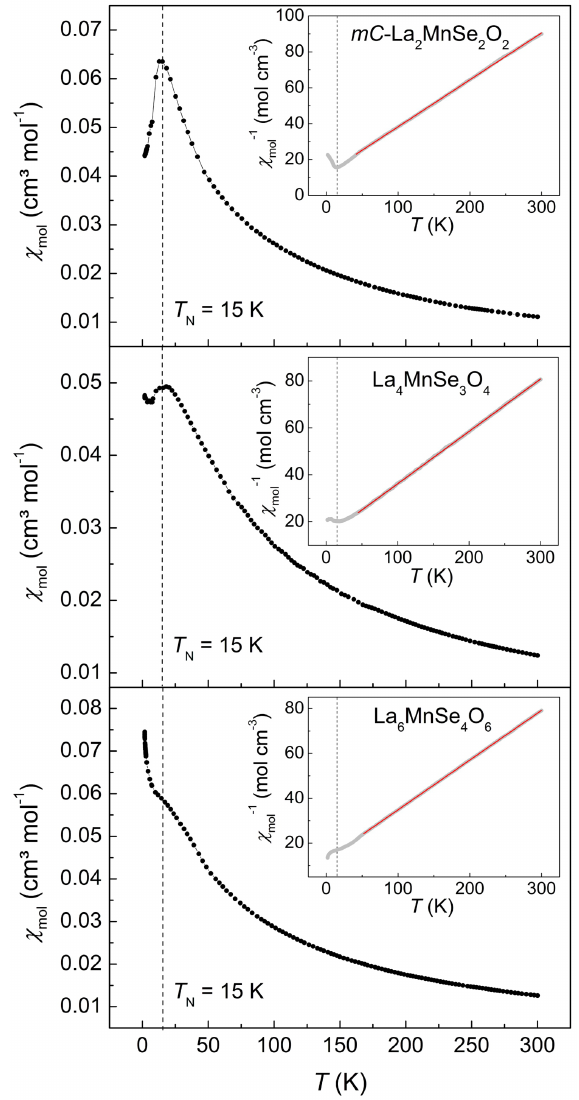
Figure 4. Magnetic susceptibilities (black, B = 1 T) and inverse susceptibilities (inset)